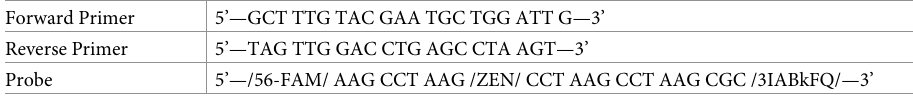
Table 1. Primer and probe sequences for the Mp R1 repeat-targeting index